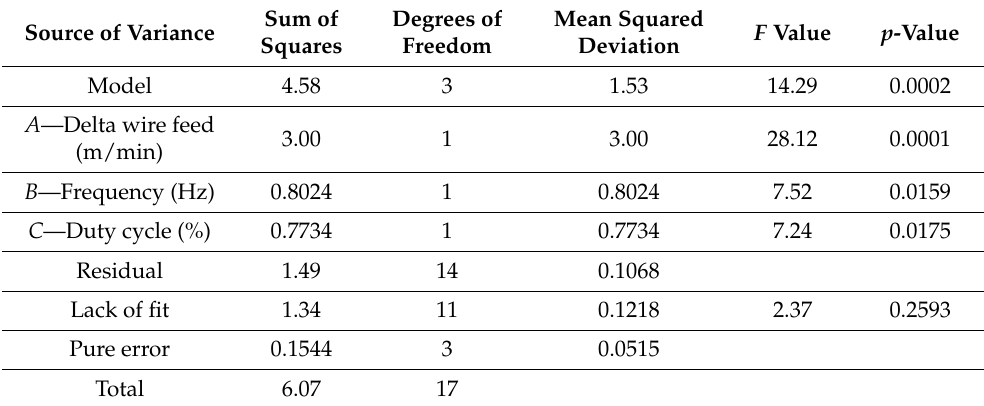
Table 9. Analysis of variance for the regression model–insufficient/excessive throat